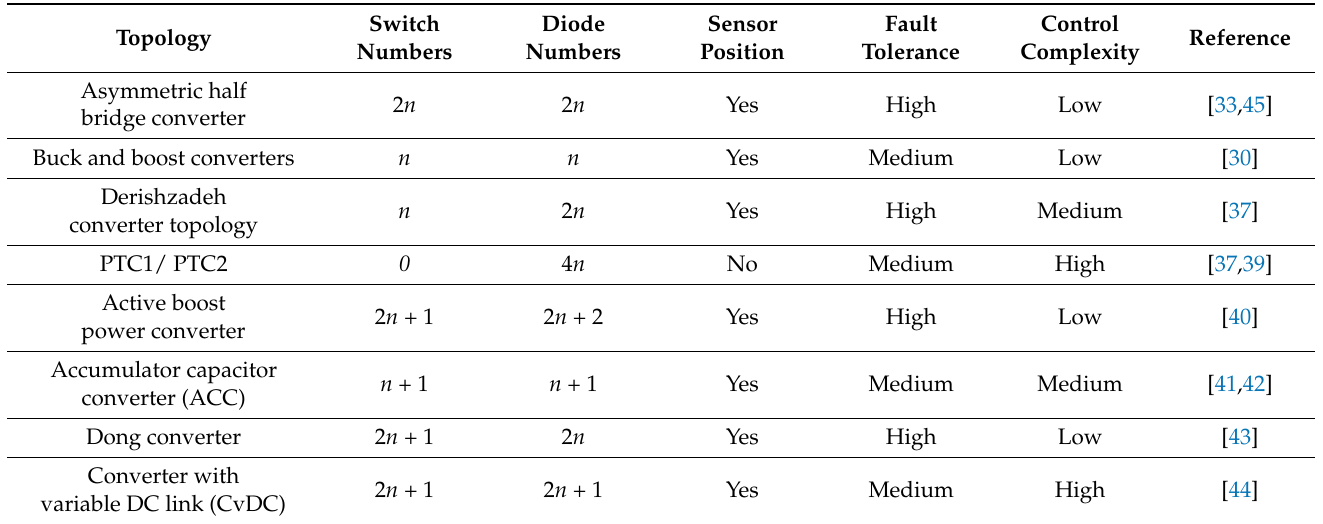
Table 2. Comparison of different converter